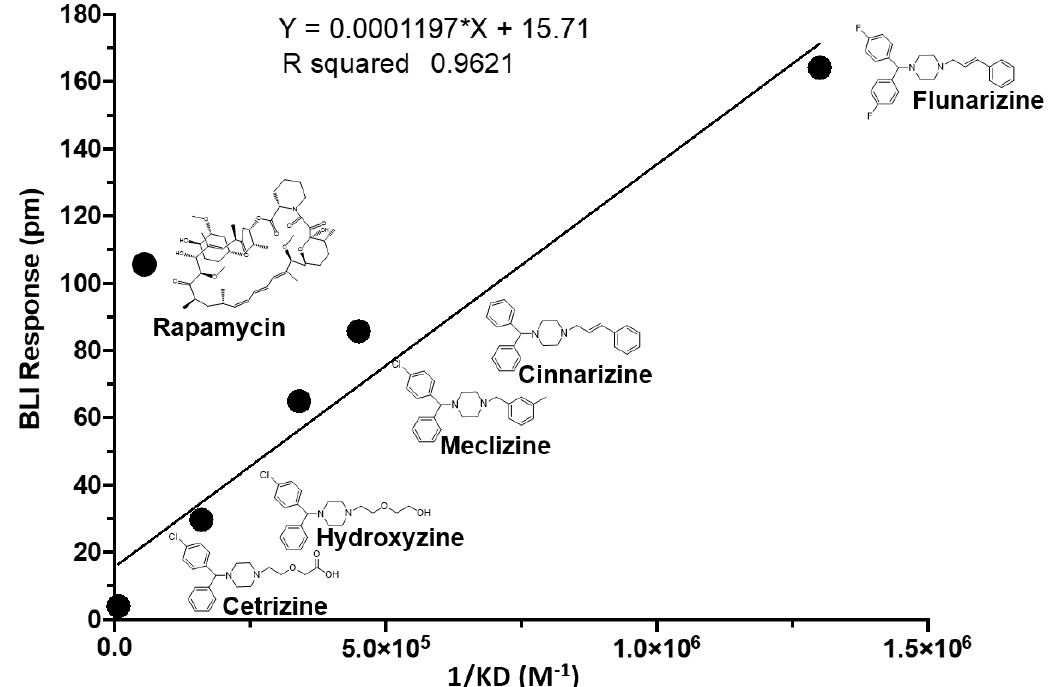
Figure 2. Affinity plotted against binding response for members of the piperazine drug class and rapamycin. The Y-axis is the response measured with bi-layer interferometry. A ffi nity measurements rapamycin. The Y-axis is the response measured with bi-layer interferometry. Affinity measurements generated with field-e ff ect biosensing is on the X-axis, as indicated. The line is linear generated with field-effect biosensing is on the X-axis, as indicated. The line is linear regression.